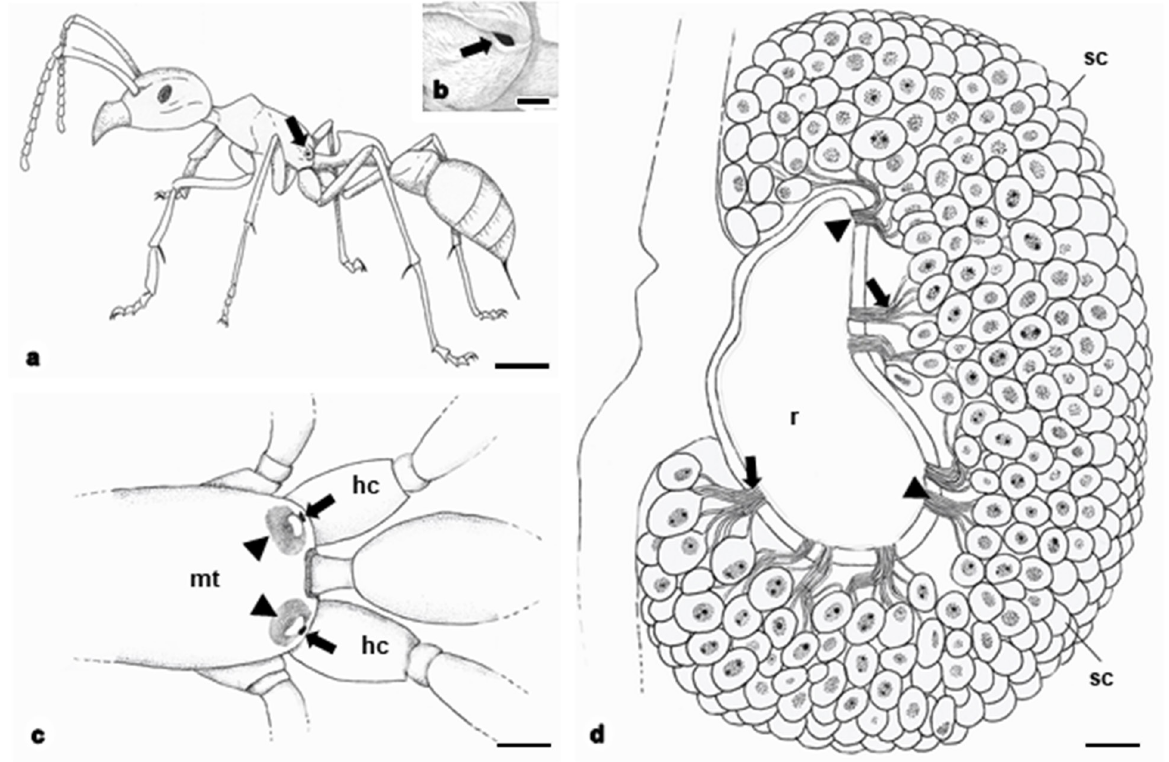
Figure 1. Schematic drawing of Paraponera clavata worker and its metapleural gland. a-c. Detail of the metapleural gland opening (arrow) in the metathorax (mt), closely to the hindcoxae (hc). In (b) detail of the gland opening (arrow). d- Metapleural gland with secretory cells (sc), collecting canaliculi (arrows) clustered in the sieve-plates (arrowheads) opening into the reservoir (r). Bar: A = 0,3 cm; B = 200 µm. C = 0,1 cm; D = 150